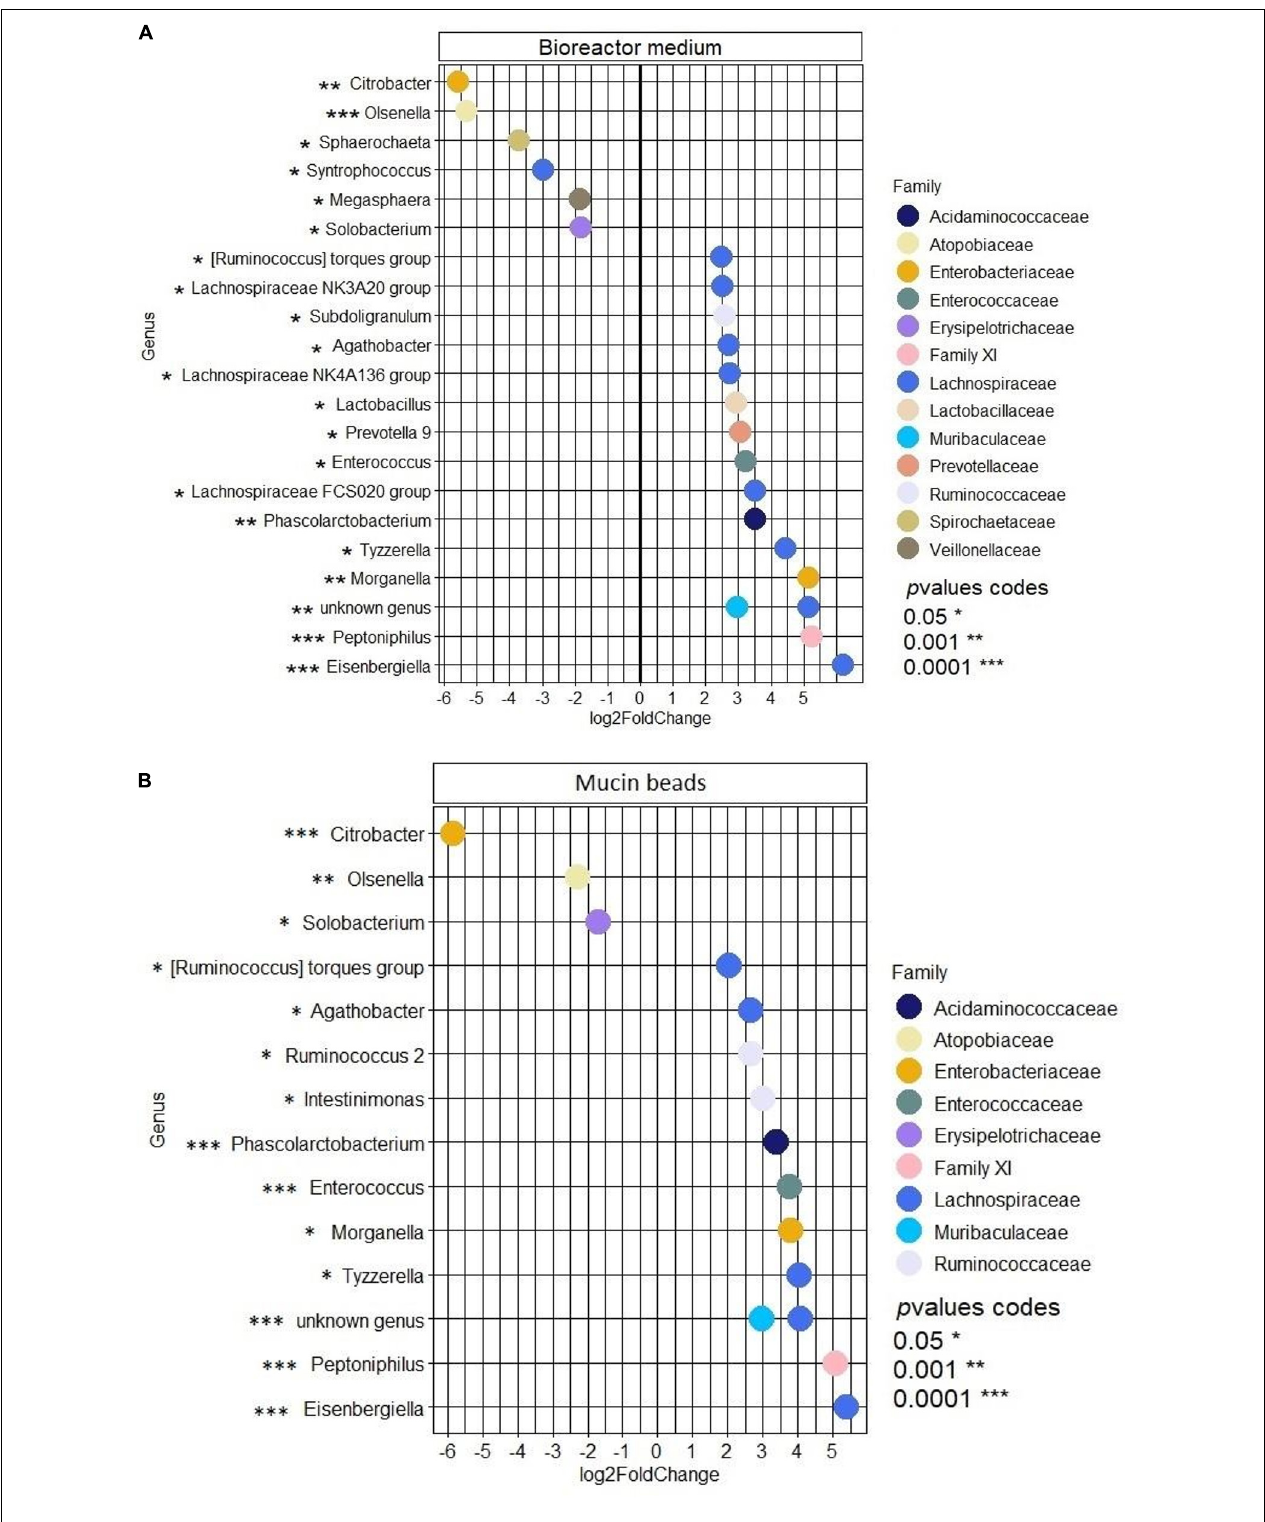
FIGURE 9 | Differentially abundant genera between the samples of the recovery period containing the ETEC Ec105 strain or not in the bioreactor medium (A) and mucin beads (B) of the MPigut-IVM. Only significant Log2 fold changes are represented on the figure. Positive Log2 fold changes indicate genera that were significantly more abundant in the presence of the pathogen. P values were corrected for multiple